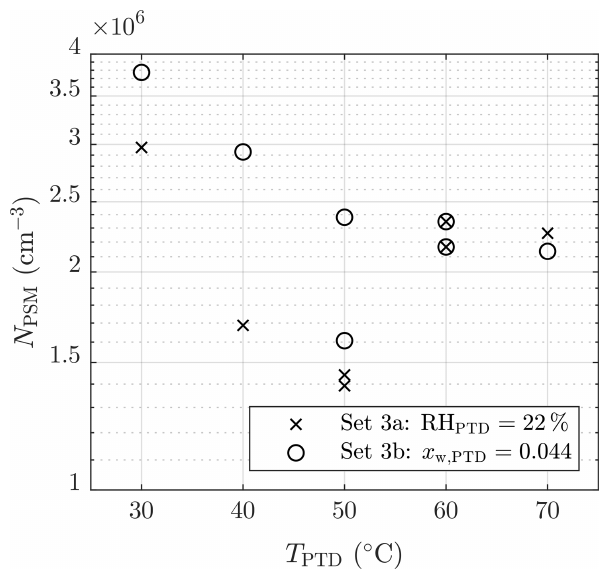
Figure 7. The measured number concentrations of the particles larger than ∼ 1 . 3nm of measurement set 3 as a function of the T of the PTD dilution air. The concentrations are multiplied by the to- tal dilution ratio of the sampling system. The error bars representing the standard uncertainties of the measured concentrations are within the marker sizes.